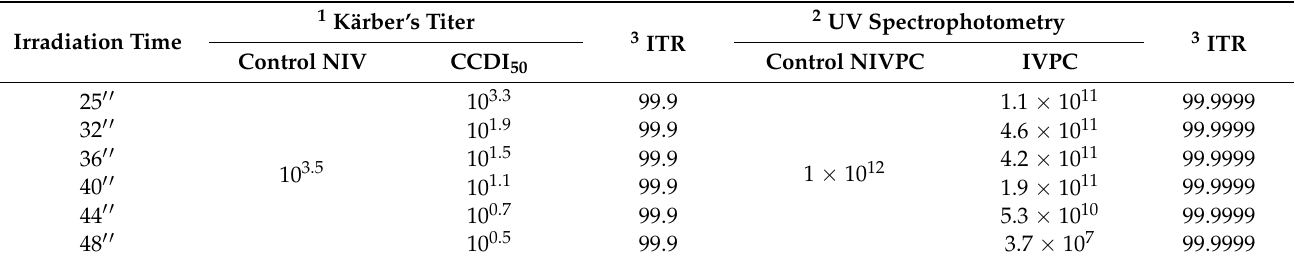
Table 4. Human coronavirus HCoV-OC43 infectious titer reduction using ultraviolet C (UV-C) 275 nm in time exposure. Analyses of cytopathic effect (CPE) and UV virial particles (VP) in infectivity assay.